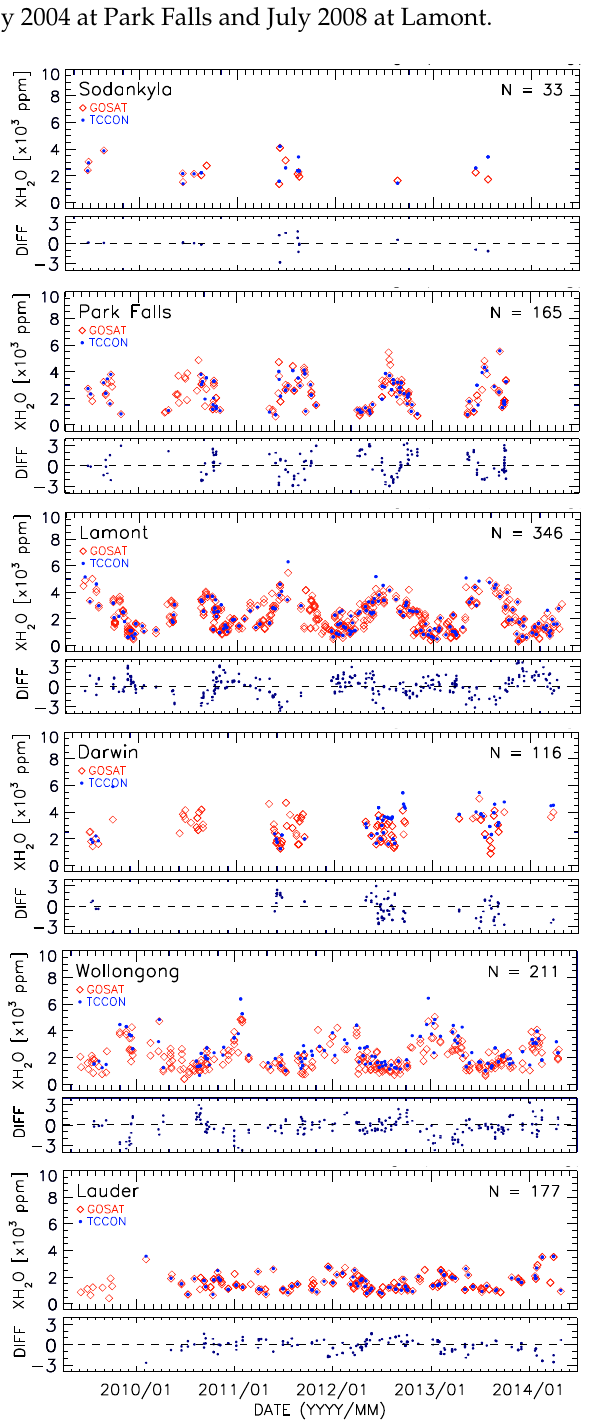
Figure 7. Time series of XH 2 O at six TCCON sites for collocated TANSO-FTS data ( ± 1 ◦ latitude/longitude, no time constraint) and for the average of TCCON measurements acquired within ± 30min of a GOSAT overpass. TCCON sites are ordered from top to bottom by decreasing latitude. For each site, the top panel shows the XH 2 O time series of GOSAT (red diamonds) and TCCON (blue circles). Bottom panel: absolute differences (GOSAT − TCCON) for spatially- and temporally-coincident